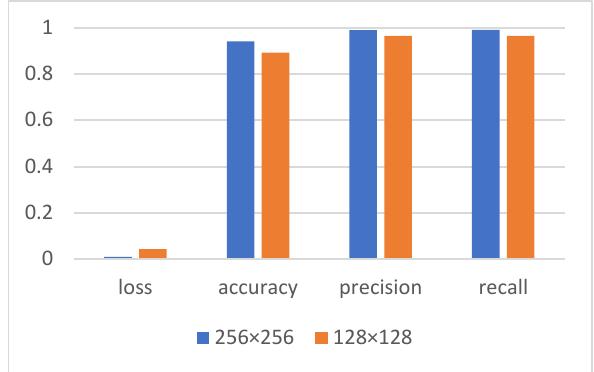
Figure 11. Different image size evaluation metrics for BFPC-Net.